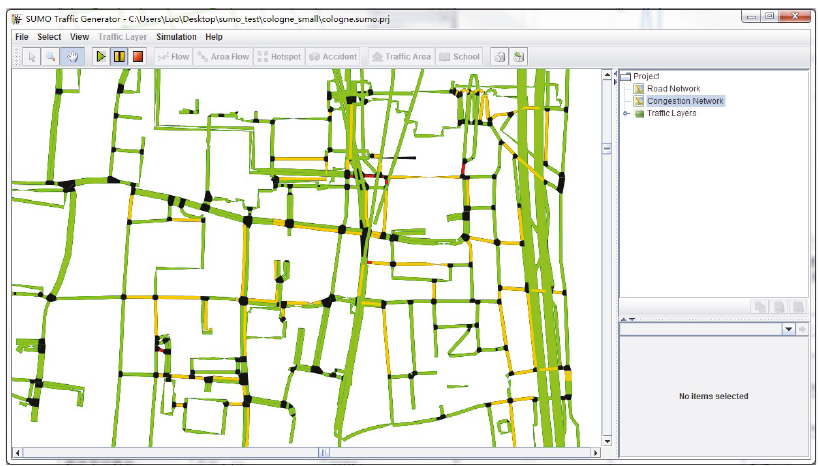
Figure 10: Congestion grade rendering for